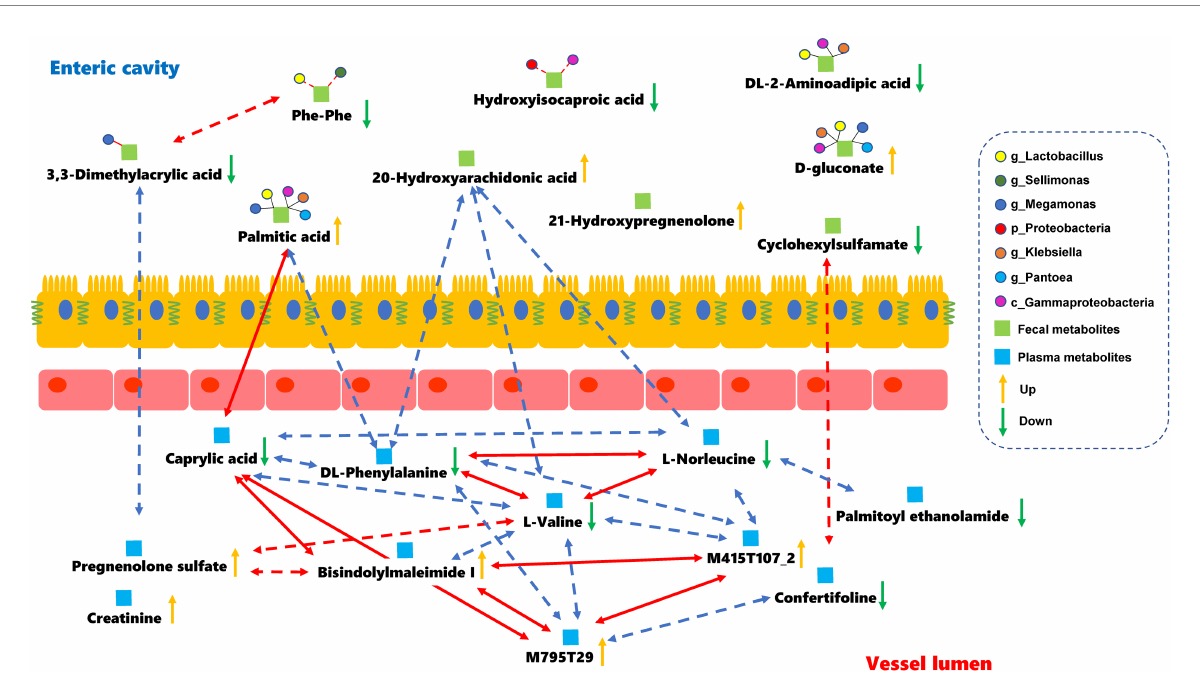
FIGURE 4 Microbes-fecal metabolites-plasma metabolites network in the full-term pregnancy. The red and blue lines represent the positive and negative relationships, respectively. The absolute value of the correlation coefficient was equal to or greater than 0.5. The dark lines indicate that there were some biological relationships between the metabolites and identified gut microbes. Dotted lines represent that the absolute value of the Pearson correlation coefficient was greater than 0.3 but less than 0.5 with statistical